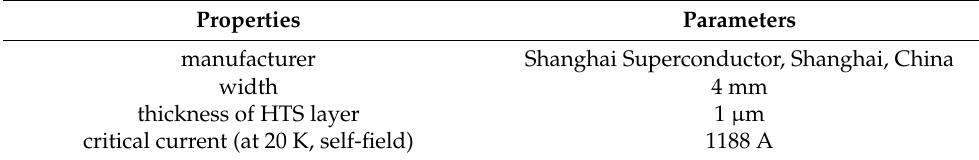
Table 1. HTS tape properties.